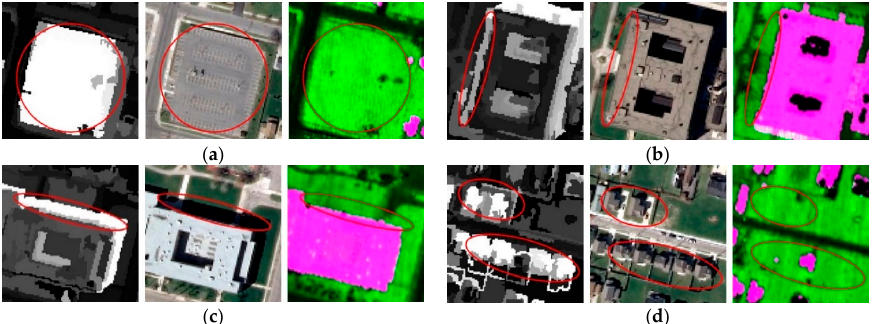
Figure 12. The change intensity image of supervised MAD (greyscale image), and its corresponding areas in the high-resolution image (true color image) and LiDAR data (pseudo-color image). The cases shown above are ( a ) real landscape change, ( b ) mis-registration, ( c ) shadows, and ( d ) another real landscape change. Higher values of the change intensity indicate the high probability to be changed.